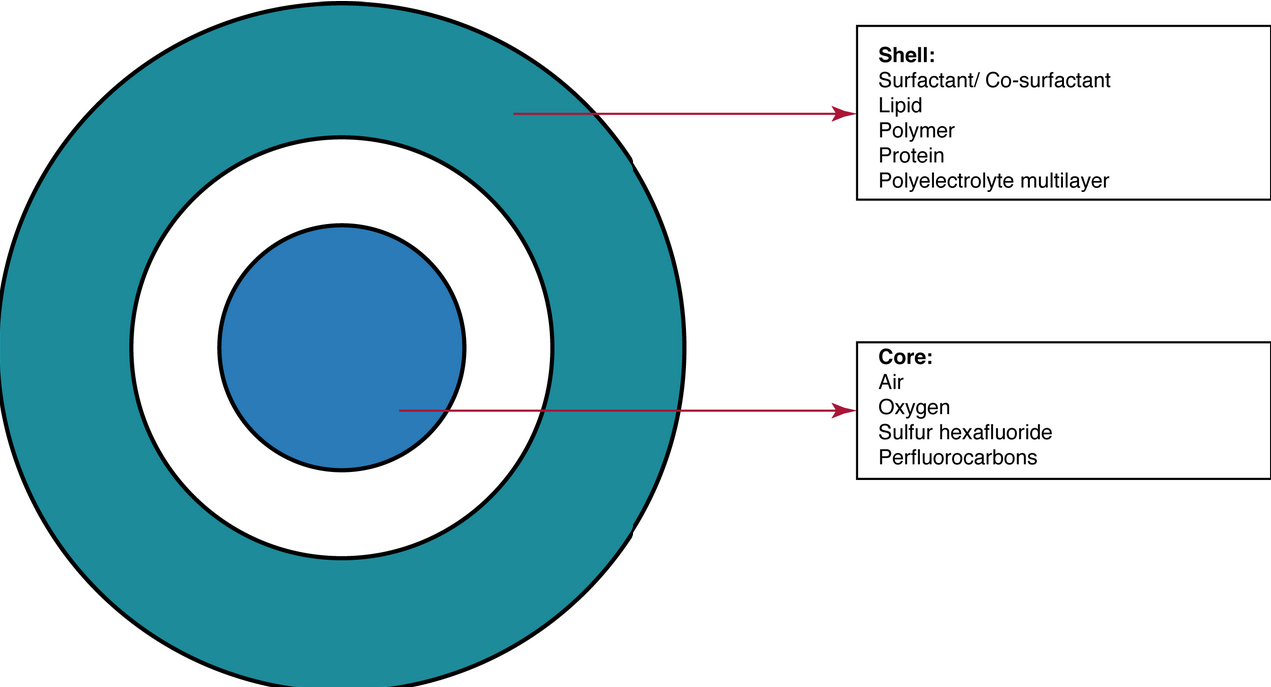
FIGURE 1 - Schematic representation of nanobubble